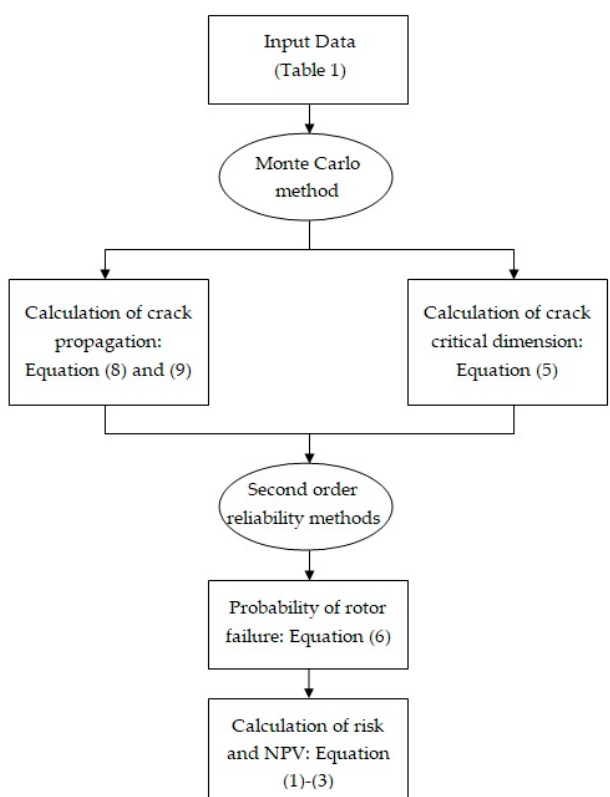
Figure 2. Flowchart for calculating the optimal time to carry out diagnostic testing of the rotor central bore.